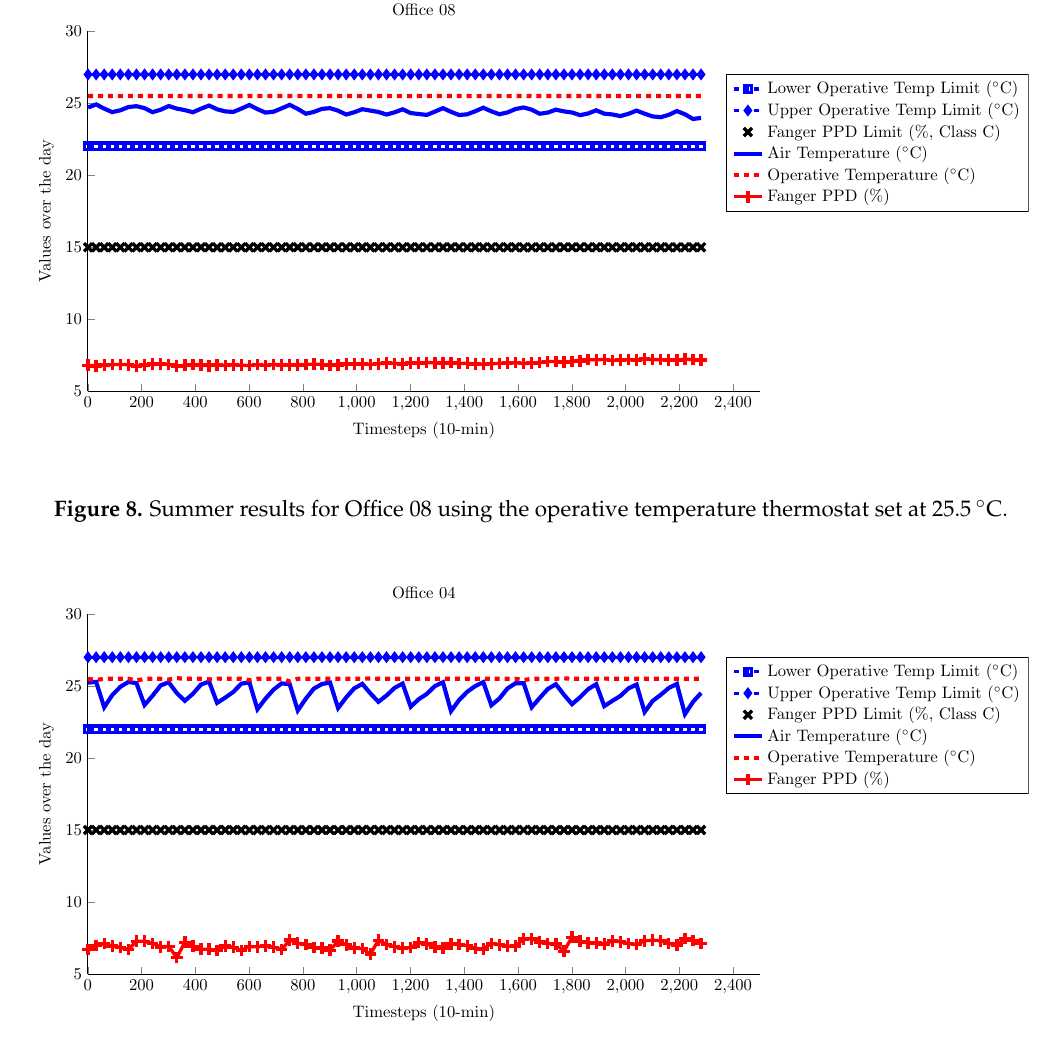
Figure 9. Summer results for Office 04 using the operative temperature thermostat set at 25.5 ◦